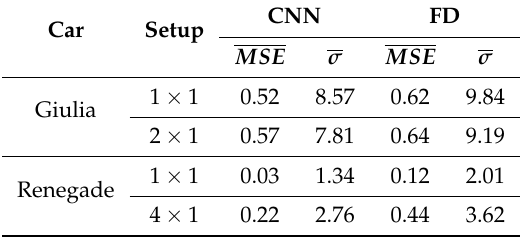
Table 7. Audio equalization in the single-channel and over-determined cases. Setup is